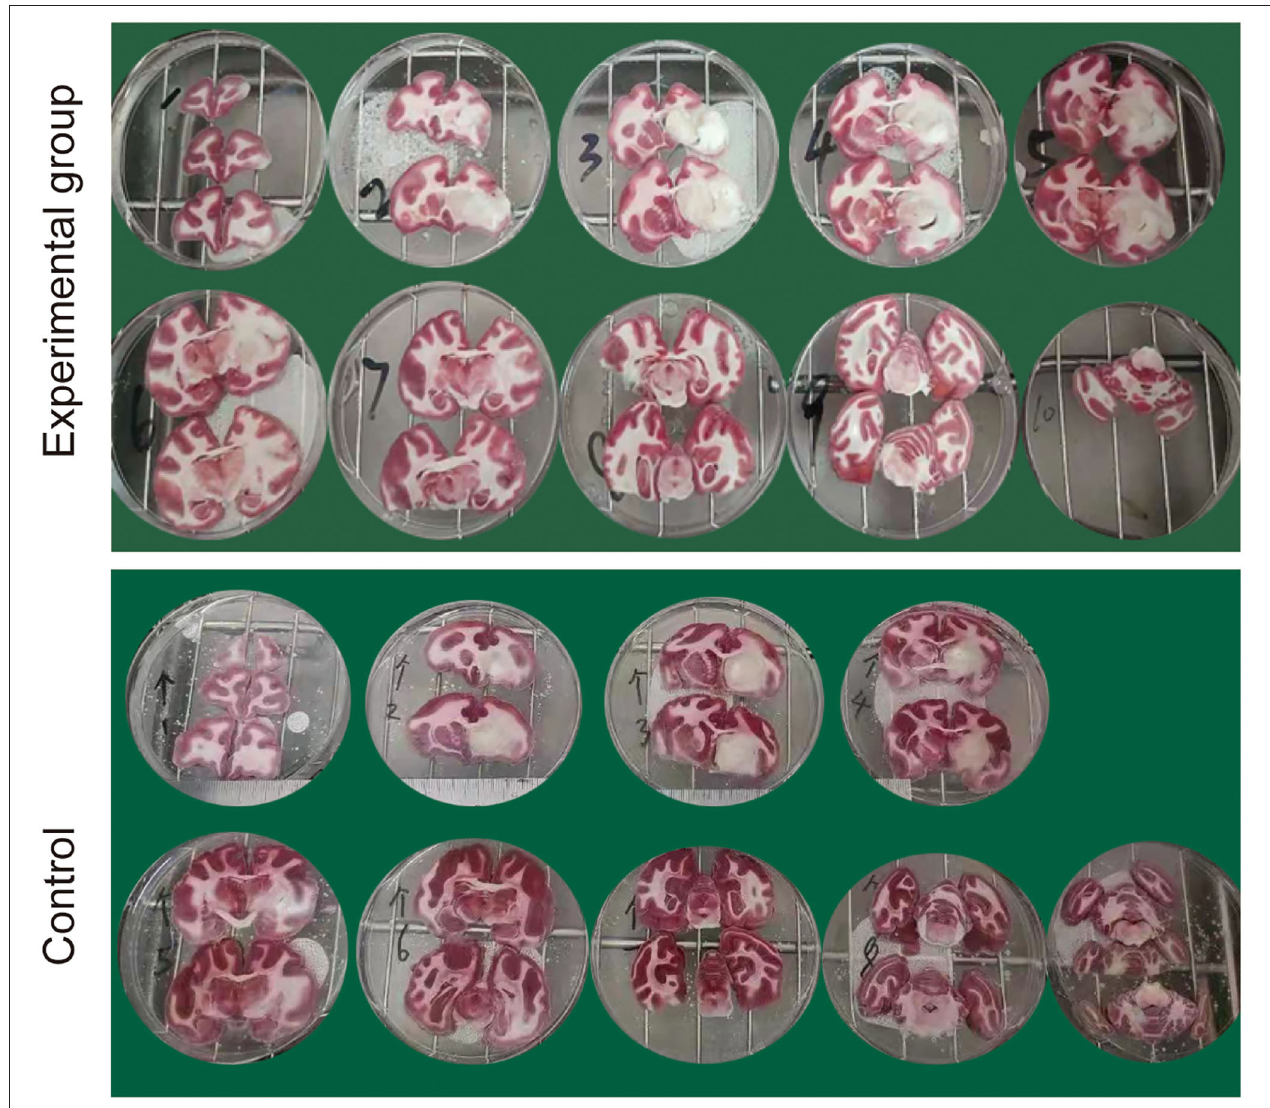
FIGURE 5 | Representative triphenyltetrazolium chloride (TTC) staining of brain sections at 8 days following the